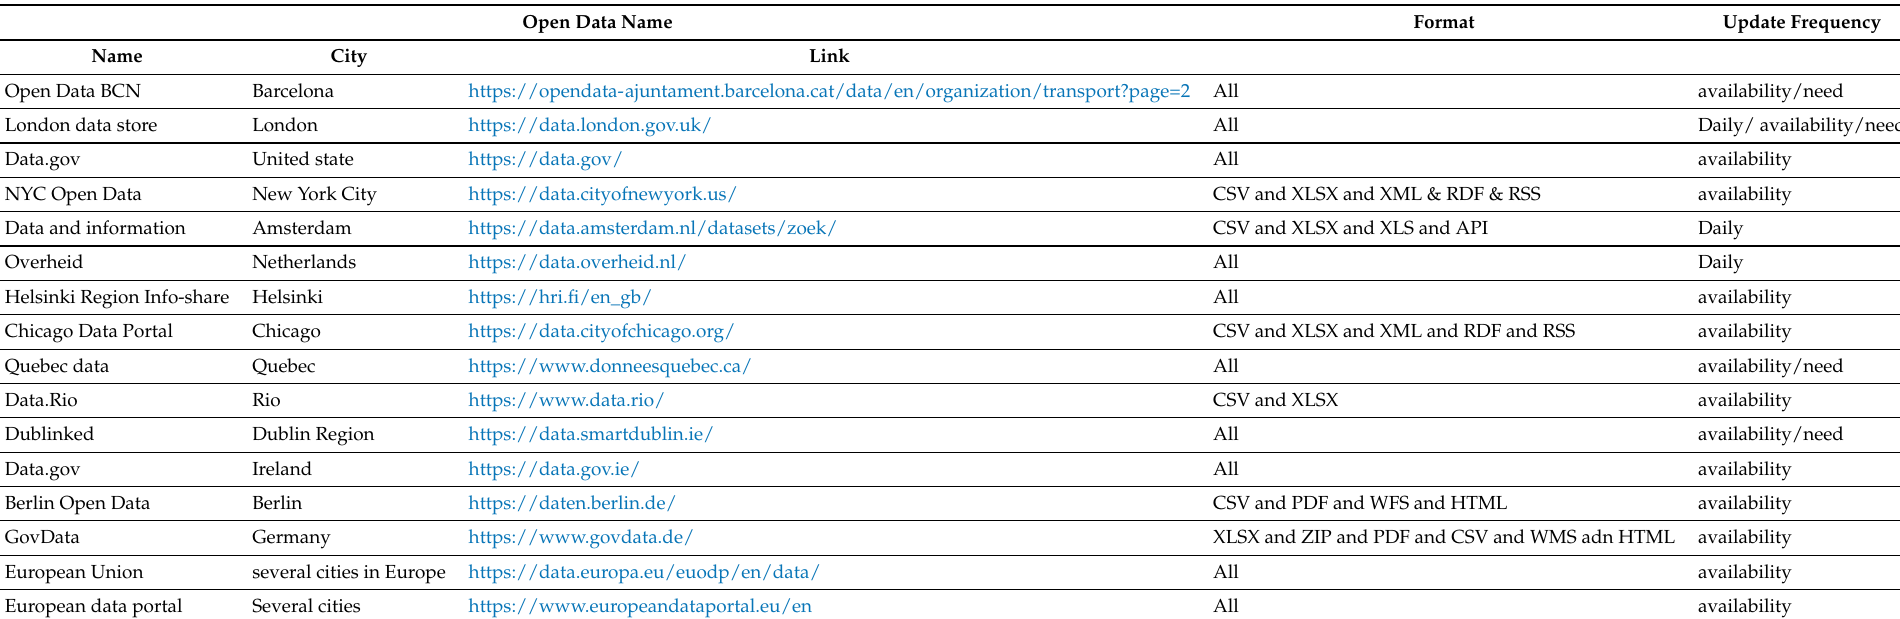
Table 1. Open data initiatives in smart cities by the type of format and frequency